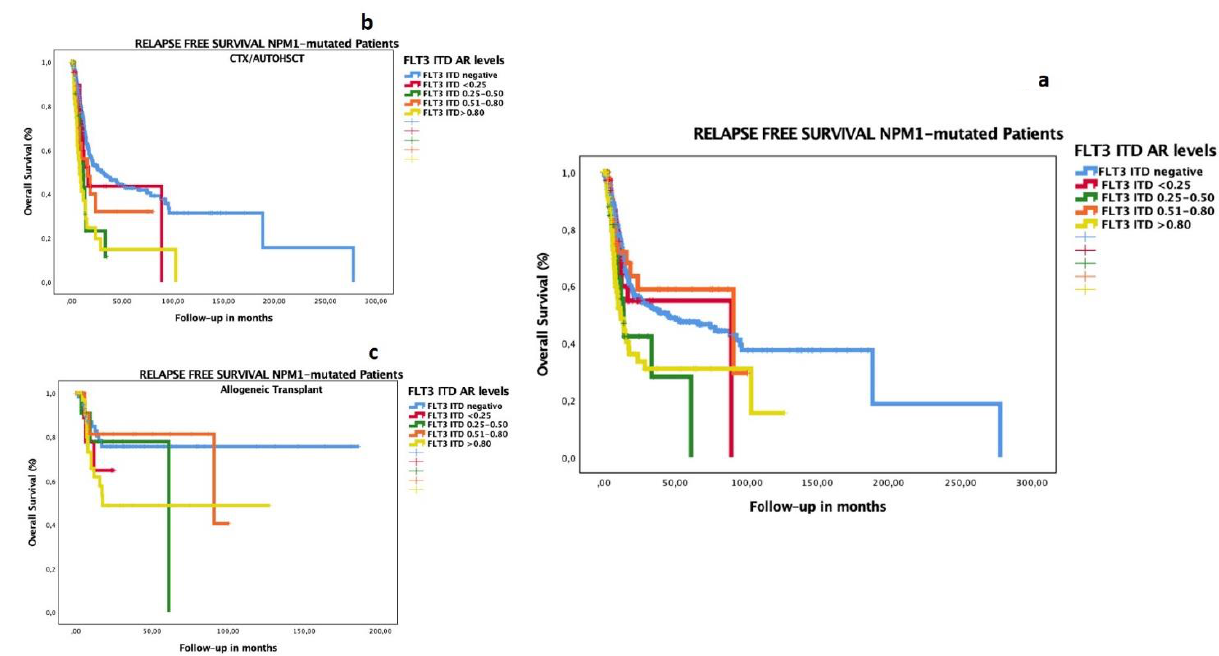
Figure 2. Impact on RFS according to FLT3 – ITD AR in patients with AML co-occurring with